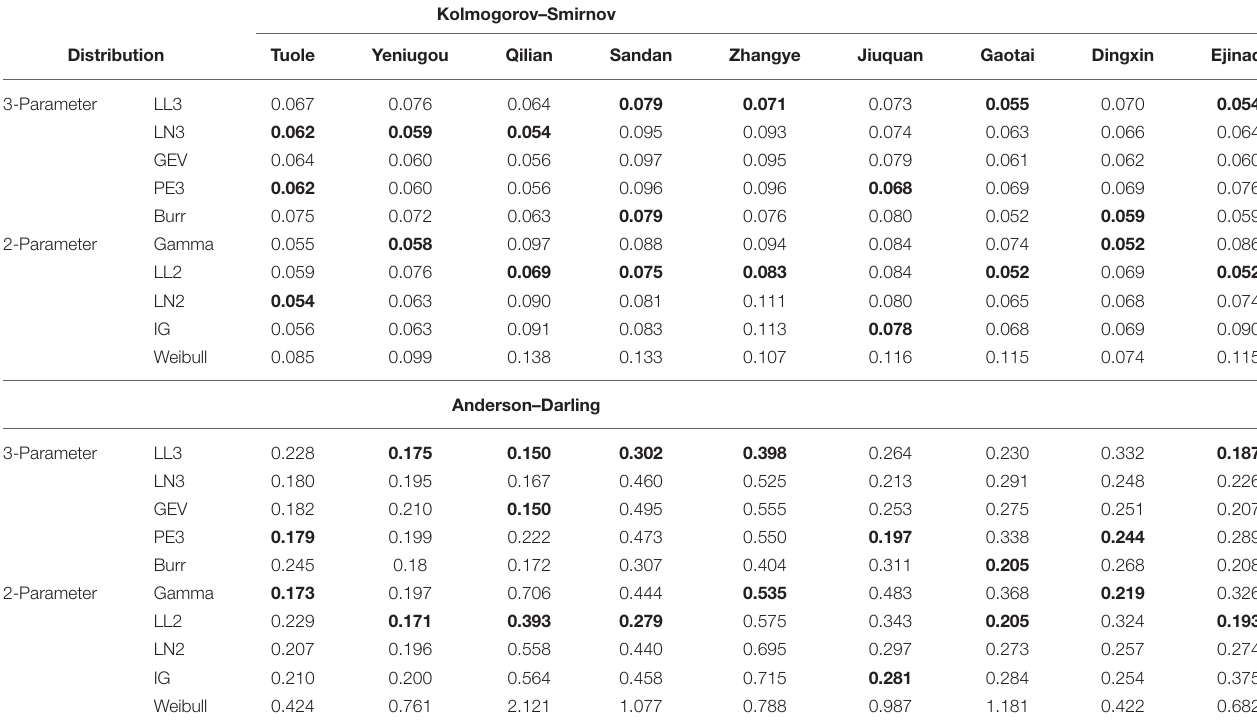
TABLE 3 | The statistic values of Kolmogorov–Smirnov and Anderson–Darling tests for January cumulative precipitation series at a of 0.05.